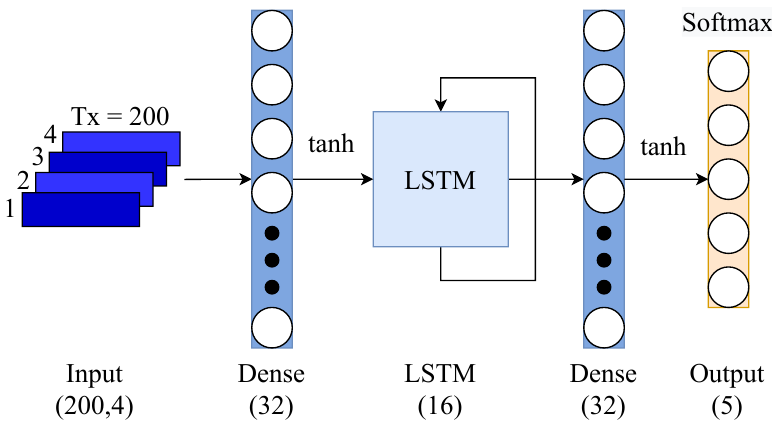
Figure 9. Recurrent Neural Network Architecture.